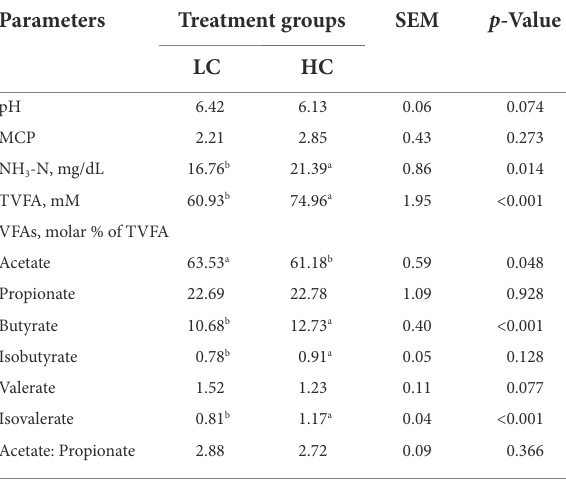
TABLE 2 Effect of high concentrate diets on ruminal fermentation parameters in yaks.